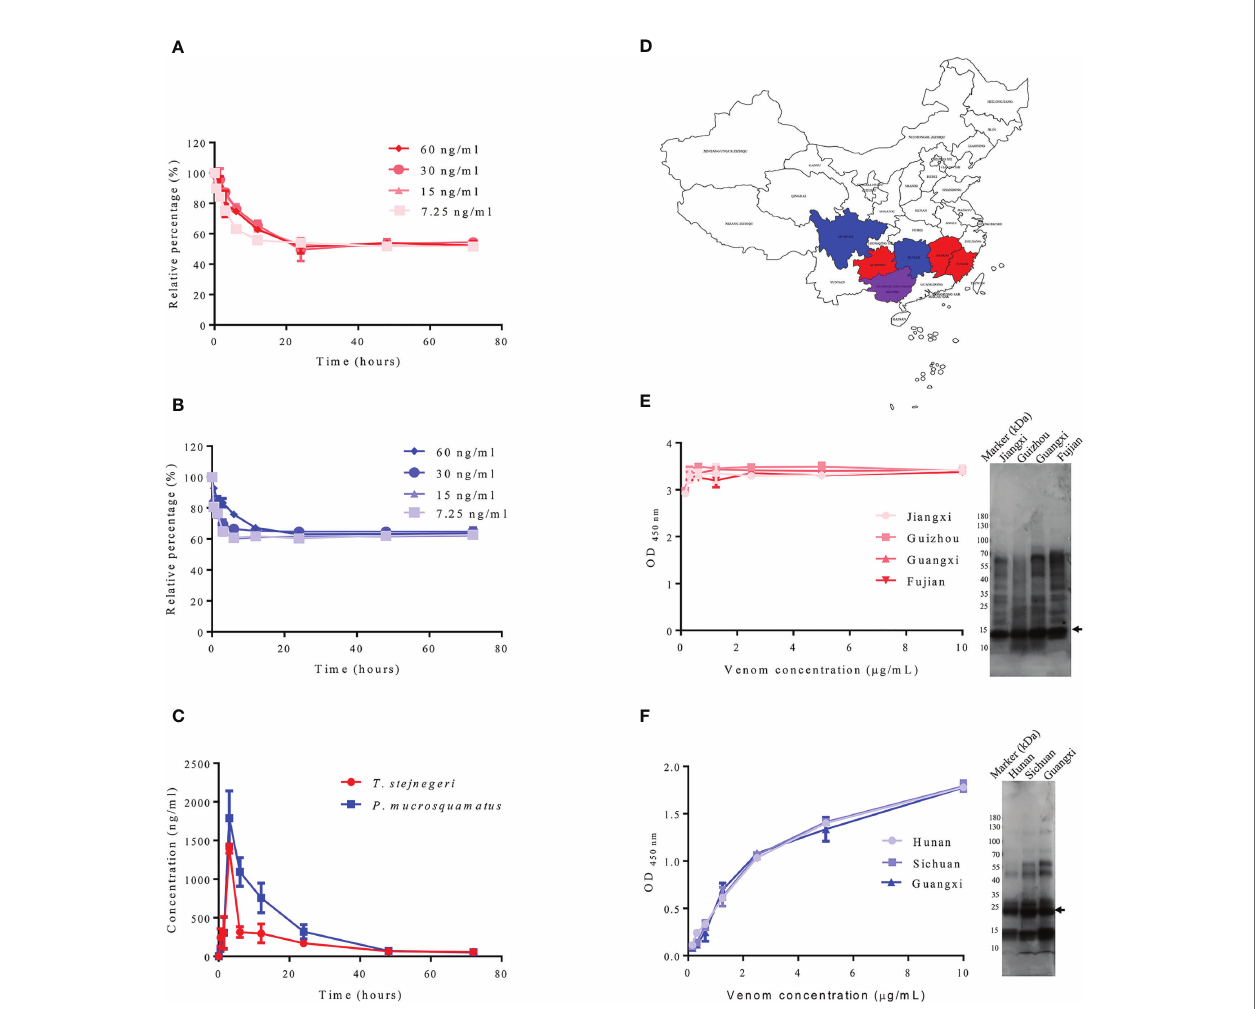
FIGURE 7 | Detection of samples containing snake venom by sandwich ELISA. Double-antibody sandwich ELISA was used to detect snake venom in plasma samples. Using in vitro experiments, different concentrations of T. stejnegeri and P. mucrosquamatus venom were incubated in plasma from healthy human donors for different times at 37°C. Results showed that T. stejnegeri (A) and P. mucrosquamatus venom (B) in plasma decreased in the fi rst 10 h and then remained at a relatively constant concentration. For in vivo simulation experiments, venom content in plasma increased gradually and peaked at 3 h, then decreased until it was undetectable after 48 h (C) . Venom of T. stejnegeri and P. mucrosquamatus from different habitats was detected by double-antibody sandwich ELISA. Venom of T. stejnegeri snakes from Jiangxi, Guizhou, Guangxi, and Fujian provinces in China [ (D) , red and purple] and venom of P. mucrosquamatus snakes from Hunan, Sichuan, and Guangxi provinces in China [ (D) , blue and purple] were collected and compared by ELISA and SDS-PAGE. Some differences were detected in the snake venom content from various areas [ (E , F) , right], but contents of PLA 2 [ (E) , left] and SVMP varied a little [ (F) , left]. PLA 2 and SVMP are indicated by